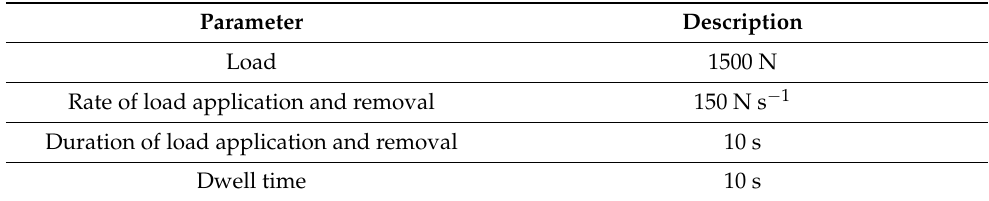
Table 4. Instrumented indentation testing